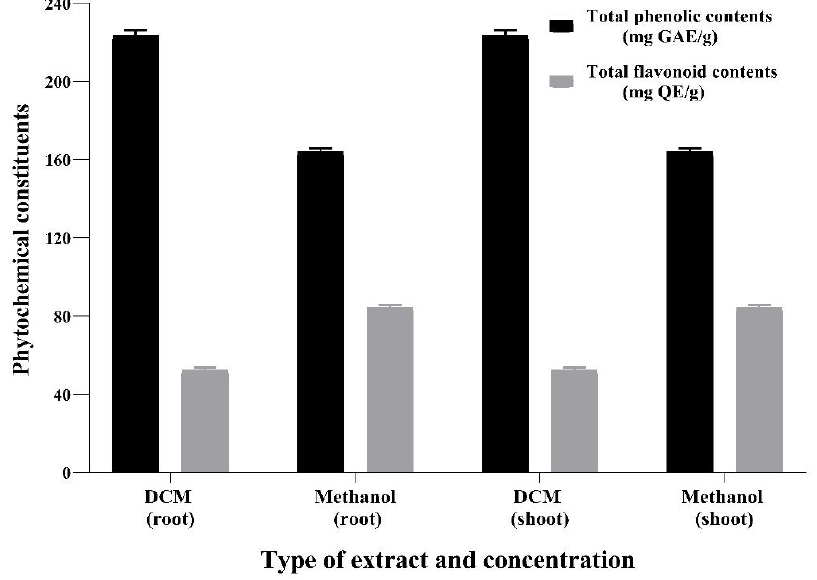
Figure 1. Total phenolic and flavonoid contents of Dryopteris juxtapostia root and shoot crude extracts. Values are presented as means ± S.D. of three measurements.